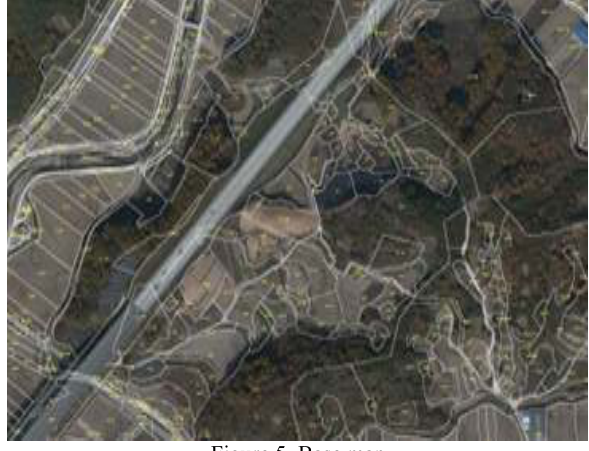
Figure 5. Base map